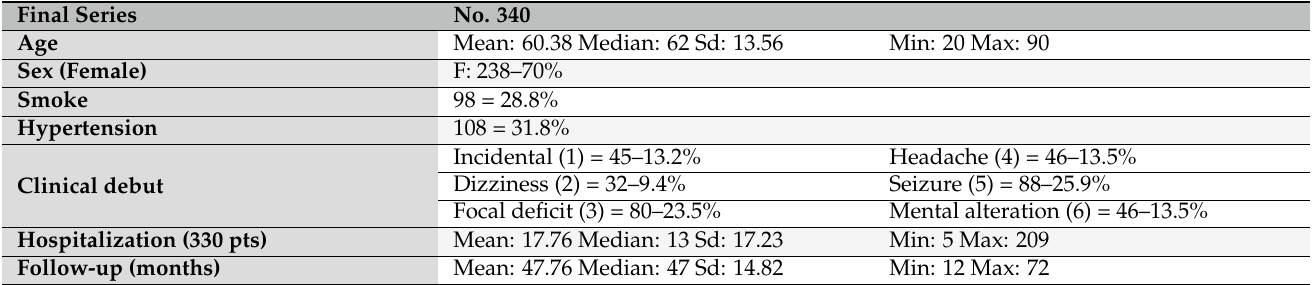
Figure 3. Flow-chart of patient selection. Table 1. The population